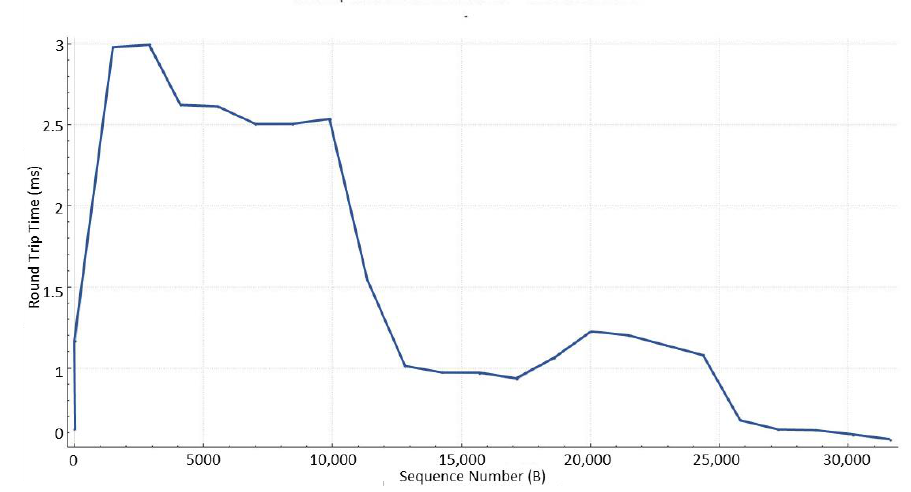
Figure 6. Non-encrypted file RTT.